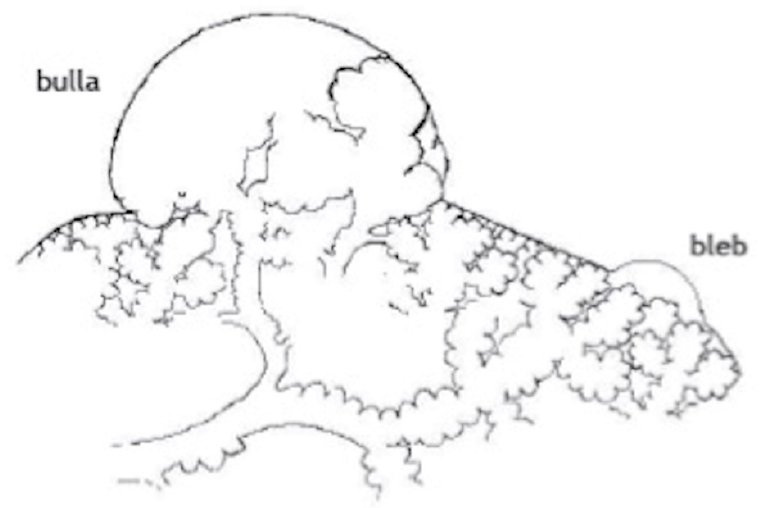
Figure 2. Schematic illustration of the anatomy of emphysema-like changes: a bleb and a bulla as described by Reid as type I and type II, respectively [13] (from Lyra et al. [14]).